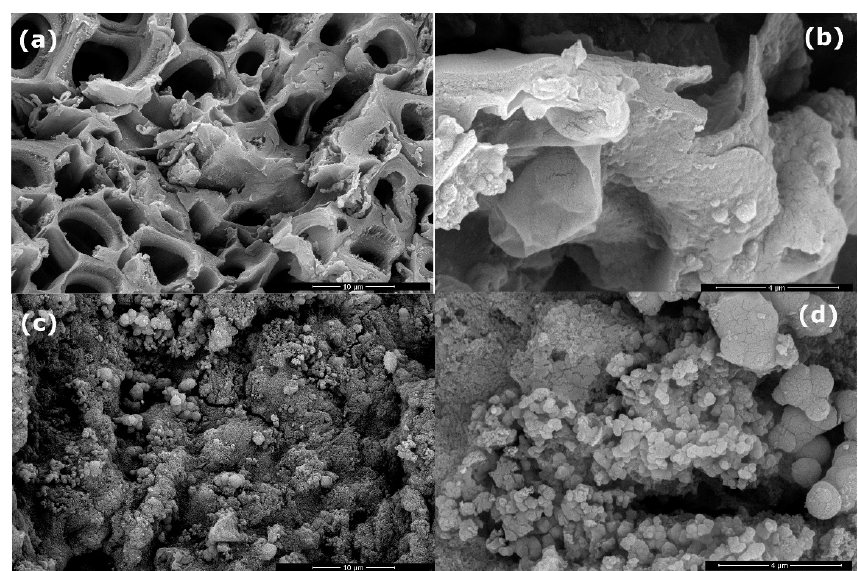
Figure 2. ( a ) TEM images of hydrochar (HC) after the microwave-assisted hydrothermal carboniza- tion treatment and ( b ) activated hydrochar (AHC) after the microwave-assisted hydrothermal car- bonization treatment and chemical activation by ZnCl 2 .